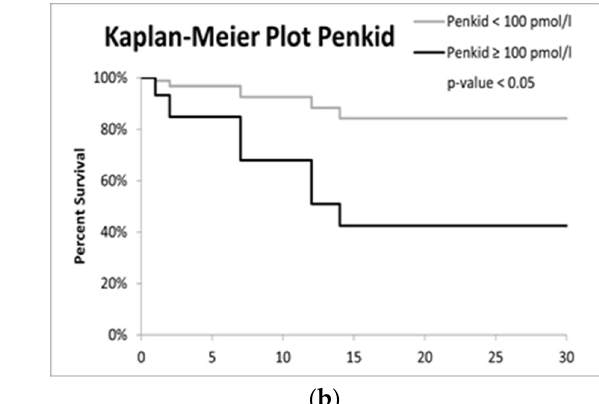
Figure 3. PenKid concentrations expressed in pmol/L. Box plots. Survivor: distribution of the penKid values of the patients who survived after 30 days ( n = 94, median = 47.5); no f.u.: distribution of penKid values in patients for whom follow-up is not available ( n = 44, median = 42.3); non-survivors: distribution of the penKid values of the patients who were dead after 30 days ( n = 15, median = 95.1). Gray lines represent the 99th percentile of normal values (100 pmol/L).